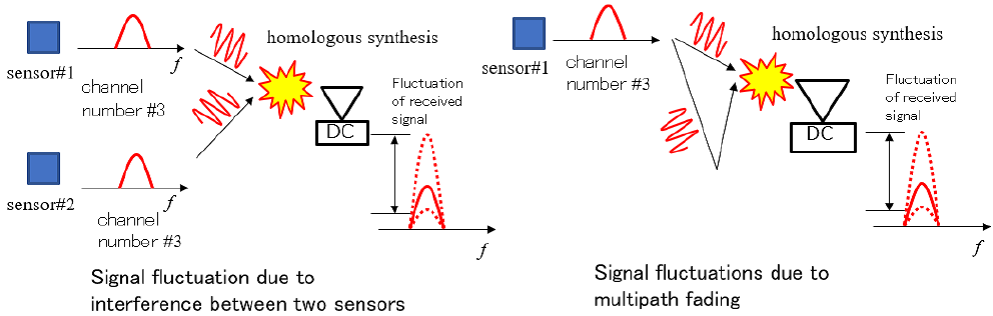
Figure 2. Detection Problem to Multiple Sensors in a